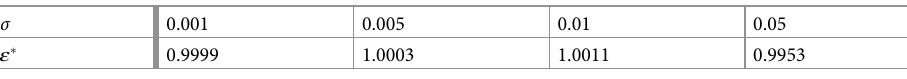
Table 1. Inverting parameter ε � under different distribution σ .